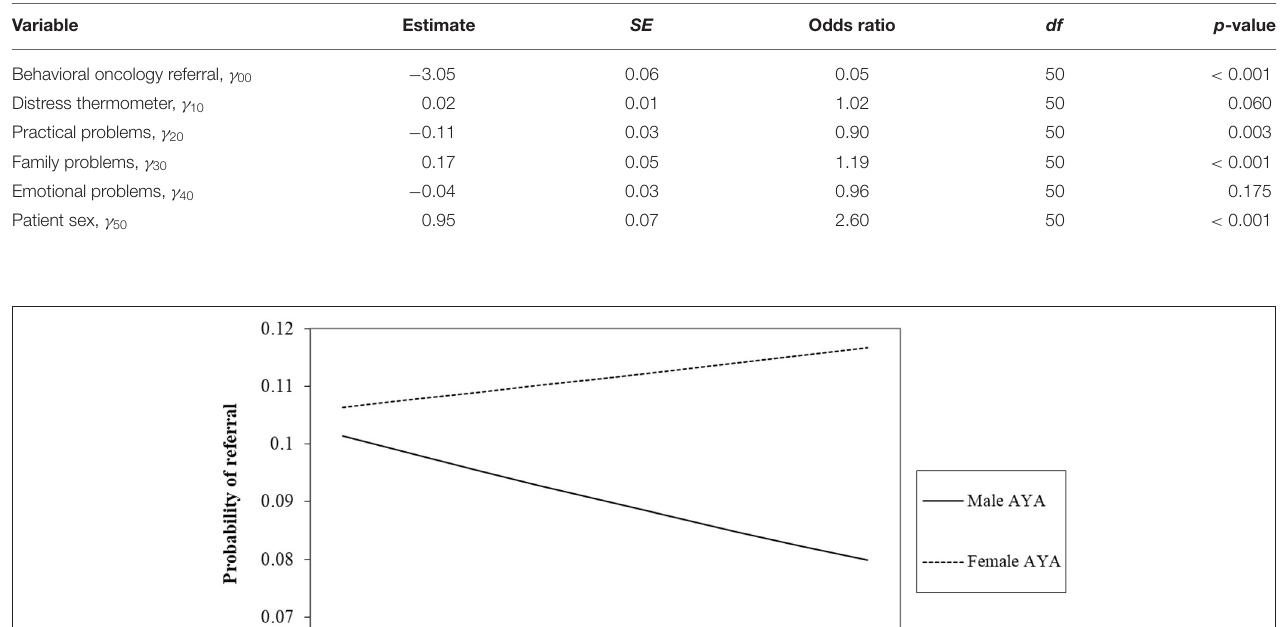
TABLE 2 | Multilevel logistics model of sex disparities in behavioral oncology referrals.